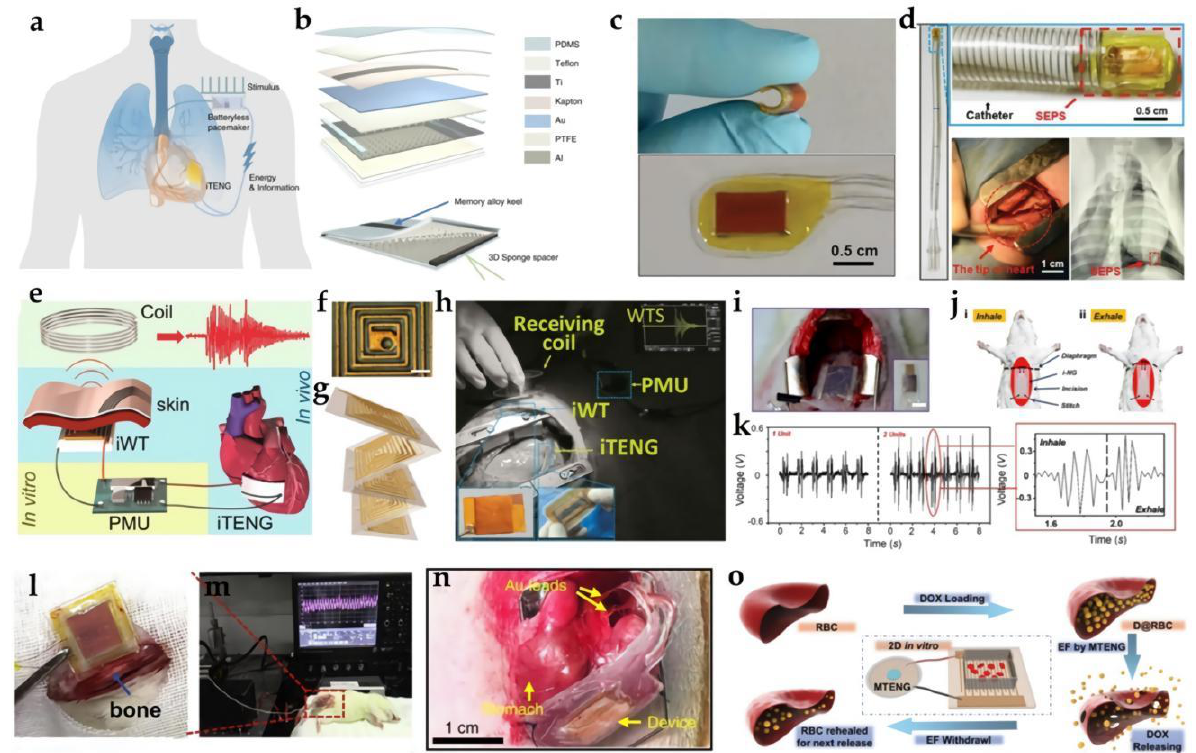
Figure 6. Implantable TENGs for cardiological biomonitoring. ( a ) Illustration of symbiotic cardiac pacemaker system. ( b ) Schematic structural diagram of iTENG. Reprinted/adapted with permission from Ref. [114]. 2019, Ouyang et al. Nature. ( c ) Photograph of the SEPS in the bending and original states. ( d ) Photograph of minimally invasive surgery with a digital radiography image of the heart implanted with a device by integration with a surgical delivery system. Reprinted/adapted with permission from Ref. [115]. 2019, Liu et al. WILEY-VCH. ( e ) Schematic diagram of the self-powered wireless transmission system based on the iTENG (iWT, implantable wireless transmitter; PMU, power management unit; WTS, wireless transmission signal). ( f , g ) Photograph of the implantable wireless transmitter. ( h ) In vivo heart rate monitoring (inset: enlarged view of the implantable wireless transmitter, iTENG, and wireless transmission signal). Reprinted/adapted with permission from Ref. [116]. 2016, Zheng et al. American Chemical of Society. ( i ) Digital image of an i − TENG implanted inside the abdominal cavity of a SD rat. The inset is an image of the i − TENG device. ( j ) Working process of the i − TENG driven by diaphragm motion during respiration. ( k ) In vivo voltage outputs measured from i − TENGs with a single unit (left) and double unit (right). The right panel is an enlarged voltage output profile within one inhale – exhale cycle. Reprinted/adapted with permission from Ref. [117]. 2018, Li et al. American Chemical of Society. ( l ) Surface of femur region im- planted with the flexible TENG. ( m ) Image of the output measurement process; a linear motor was used to pull the leg of an SD rat through a line [19]. ( n ) Implanted VNS device with Au leads being connected to anterior and posterior vagal trunks. Reprinted/adapted with permission from Ref. [118]. 2018, Yao et al. Nature. ( o ) Schematic illustration showing the loading of DOX into RBCs and the subsequent integration of MTENG to realize controlled DOX release. Reprinted/adapted with permission from Ref. [119]. 2019, Zhao et al. WILEY-VCH. Similarly, Ryu et al. explored a high-performance inertia-driven triboelectric nano- generator (I − TENG) based on body motion and gravity [120]. Based on body motion and gravity, the generator used amine-functionalized poly-(vinyl alcohol) (PVA-NH 2 ) and perfluoroalkoxy (PFA) as triboelectric materials to obtain a cylindrical I − TENG with a ra- dius of 1.5 cm and a height of 2.4 mm. The author also successfully used I − TENG stacked in vivo in the preclinical test and gathered real-time output voltage data through the low- power Bluetooth information-transmission system. In addition, a self-charging pace- maker system using I − TENG to charge its battery was successfully demonstrated. The synchronous stacking structure to realize the superposition of current waveform can grad- ually increase the peak current value without additional components so that the I − TENG stacked in five layers can produce 136 V peak and 2 μA peak cm − 3 . Future manufacturing work